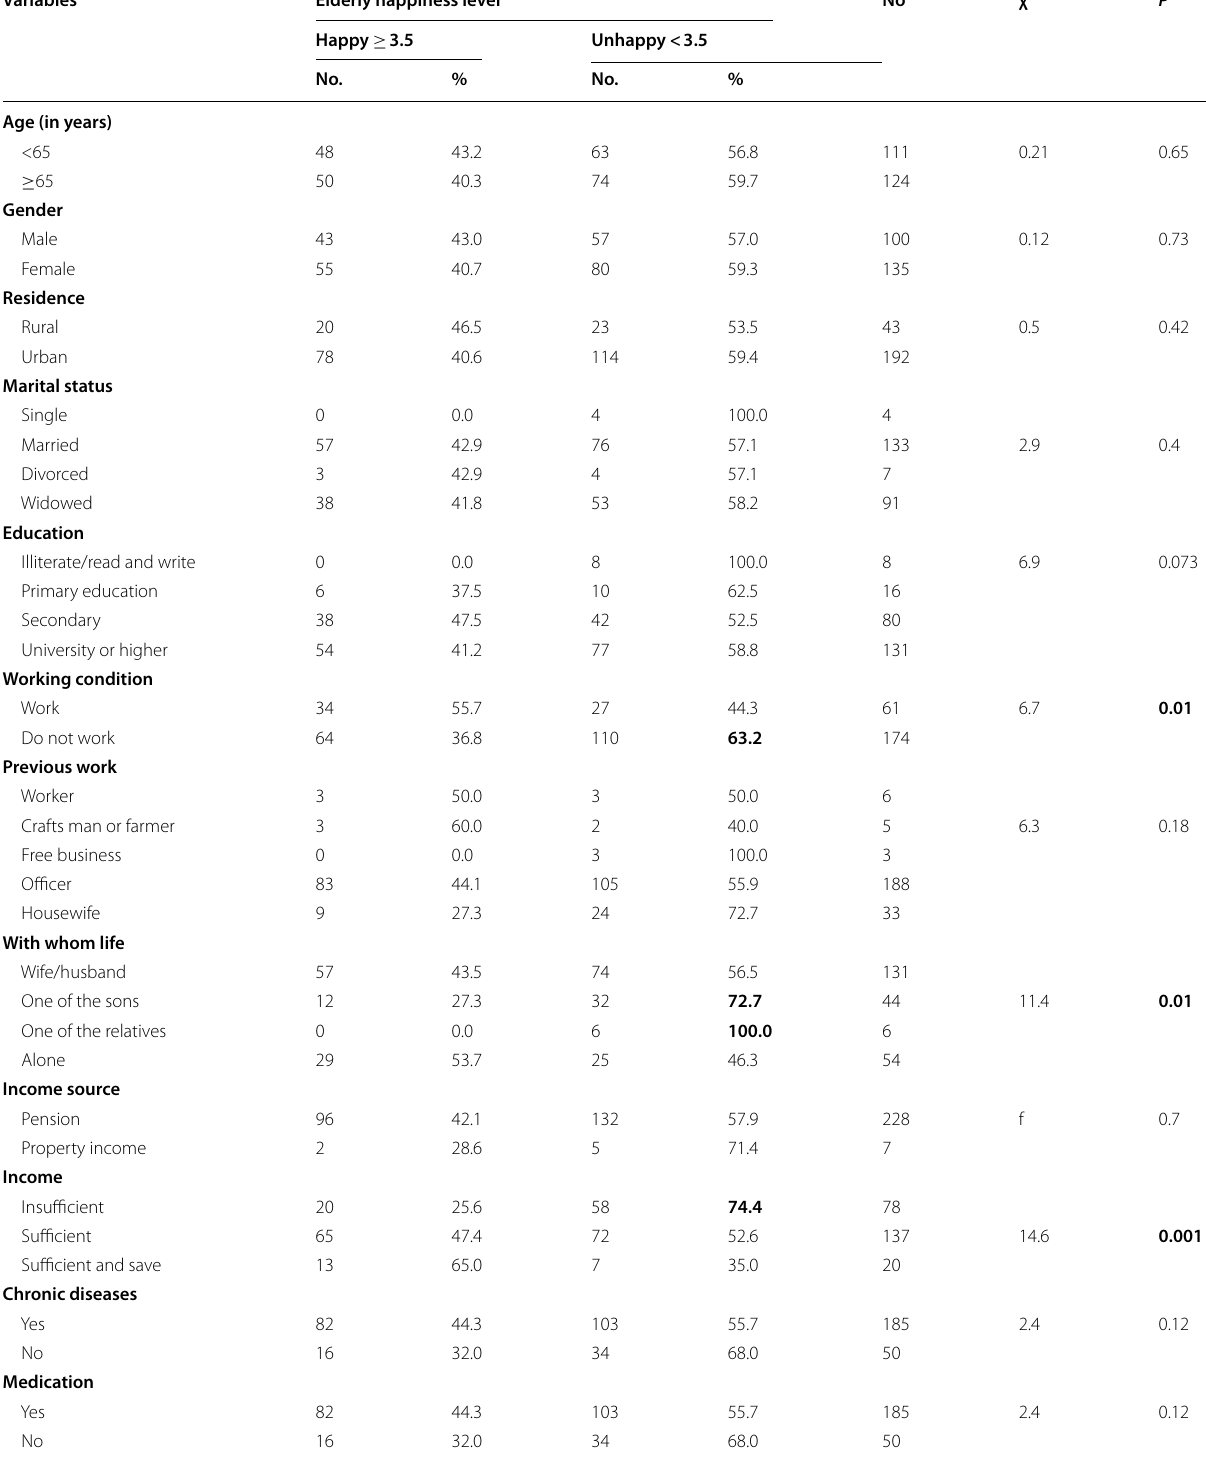
Table 6 Relations between elderly happiness level, among studied elderly people and their demographic characteristics ( n